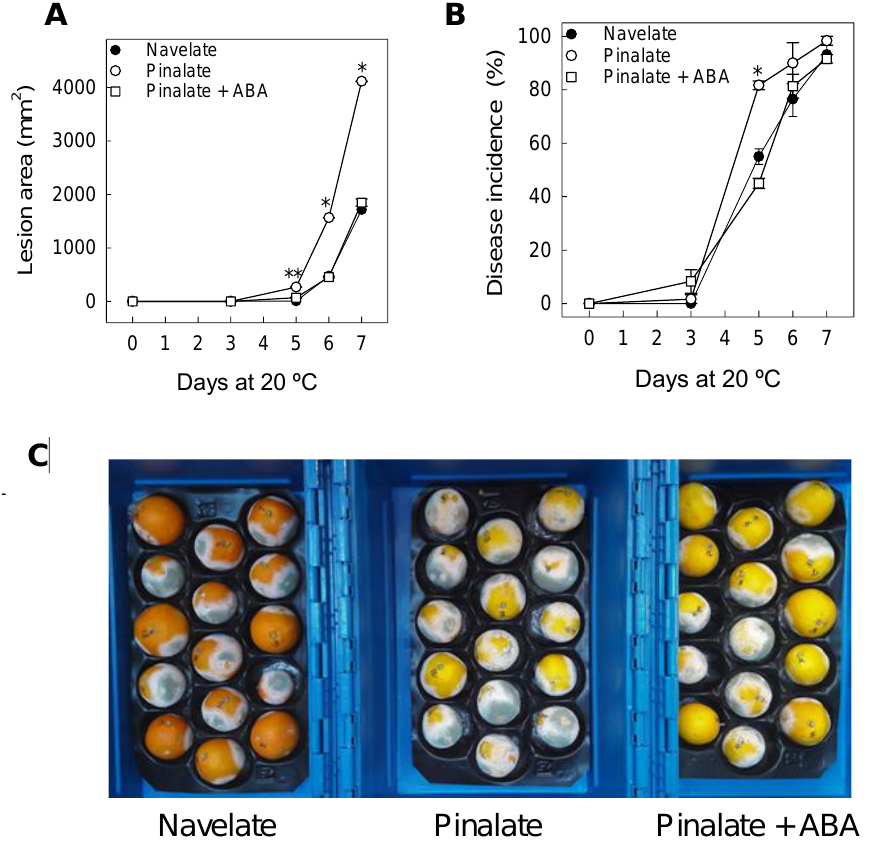
Figure 1. Differences in the susceptibility of Pinalate and Navelate fruit to infection by P. digitatum . ( A ) Changes in the lesion area of the macerated zone of Pinalate ( ) and Navelate fruit ( ⚫ ) and of the Pinalate fruit treated with ABA 1 mM (□); ( B ) Changes in the percentage of decay in the same samples; ( C ) Picture of Navelate, Pinalate, and the ABA-treated Pinalate fruit infected (8 dpi) with P. digitatum . The fruit were inoculated with P. digitatum (10 4 conidia mL − 1 ) at a depth of 4 mm. The error interval indicates the standard error of the estimated mean value. * denotes no significant differences ( p ≤ 0.05) between the Navelate and Pinalate fruit treated with ABA for the same storage period, but their mean values were significantly lower than those of the Pinalate fruit. ** represents significant differences ( p ≤ 0.05) between the parental and both the mutant fruit treated or not with ABA.